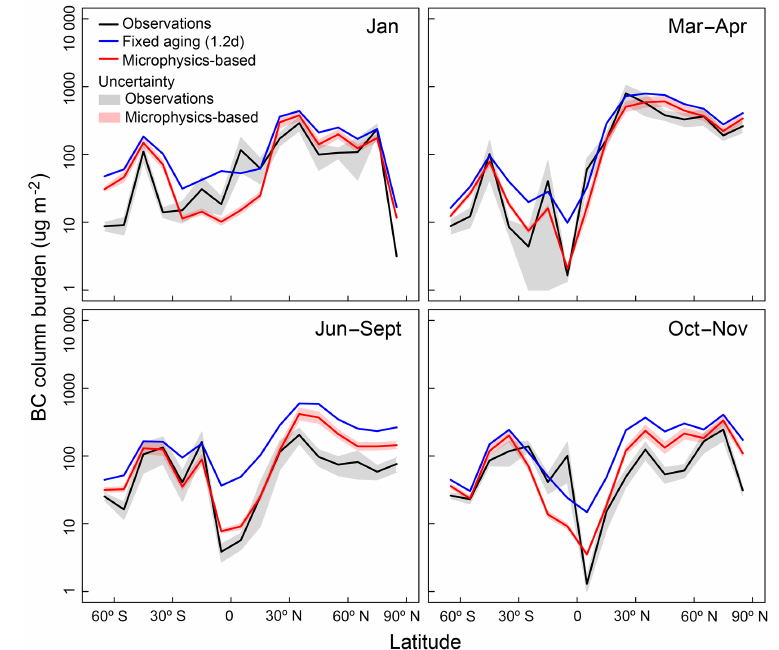
Figure 8. Latitudinal distributions of HIPPO observed (black) and GEOS-Chem simulated BC column burden (µgm − 2 ) in different seasons. The column burden is computed by integrating vertical profiles from the surface to 250hPa ( ∼ 10km) in 10 ◦ latitude bins. Model results using a fixed BC aging (blue) and a microphysics-based aging (red) are shown. Also shown are the 1 σ uncertainties of observations (grey) and model results (light red) from microphysics-based sensitivity simulations (see Table 1 and text for